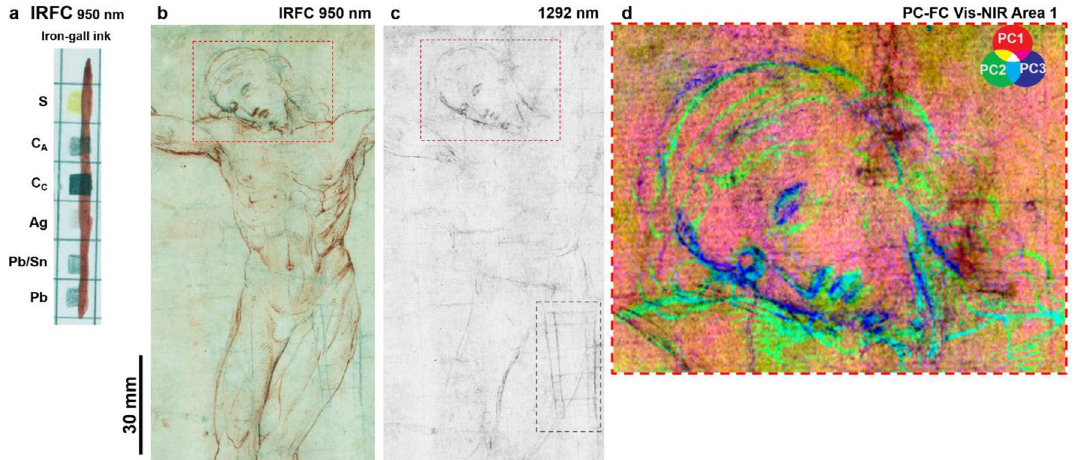
Figure 3. ( a ) IRFC at 950 nm of the reference materials where the iron-gall appears red, while Pb and the carbon-based (C A and C C ) materials grey/black; ( b ) IRFC at 950 nm where the iron-gall ink lines take on a typical reddish hue; ( c ) NIR image centred at 1292 nm showing the sketch lines realized with a carbon-based material and a lead point and the watermark (dashed rectangle) in bottom right corner; ( d ) PC-FC image (area marked with red dashed rectangle in ( b ) and ( c ) comprising the complete spectral range evidencing the difference between the preliminary sketch (dark blue) and the iron-gall ink drawing (light